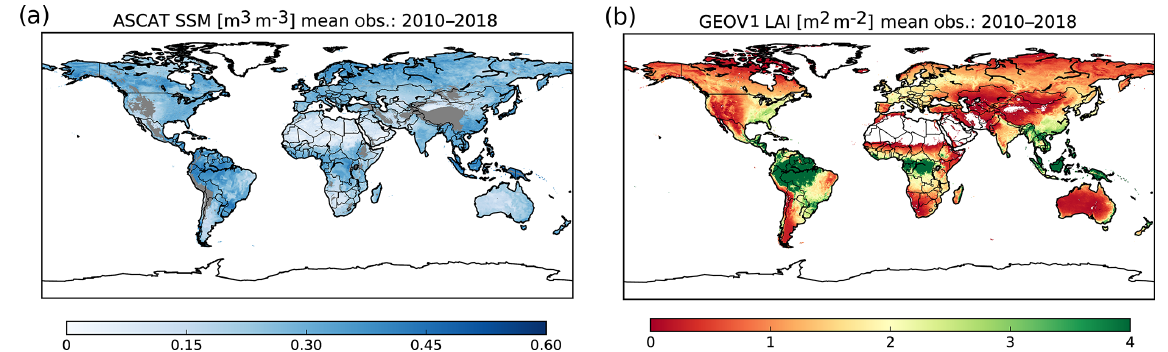
Figure 1. (a) Surface soil moisture (SSM) from the Copernicus Global Land Service (CGLS) for pixels with less than 15% of urban areas and with an elevation of less than 1500ma.s.l. (b) GEOV1 leaf area index (LAI) from CGLS, for pixels covered by more than 90% of vegetation, averaged over 2010 to 2018. SSM is obtained after rescaling the ASCAT Soil Wetness Index (SWI) to the model climatology; grey areas in (a) represent filtered-out data (see Sect. 2.3).